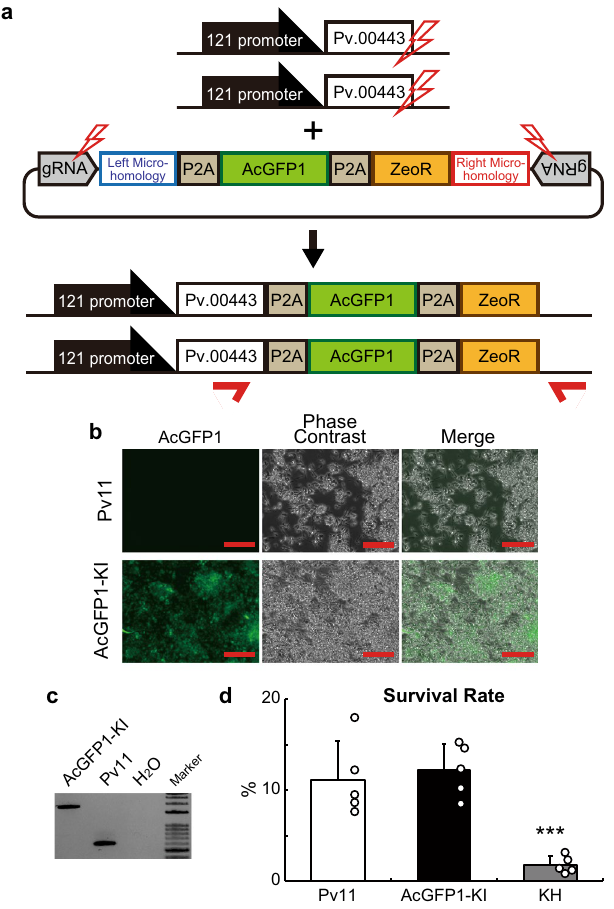
Figure 1. Insertion of the AcGFP1 and zeocin resistance (ZeoR) genes into the 5 ′ flanking site of the stop codon of the Pv.00443 gene. ( a ) The PITCh scheme for AcGFP1 and ZeoR knock-in is shown; the Cas9- and gRNA-expression vectors and the donor vector harboring AcGFP1 and ZeoR genes were transfected into Pv11 cells. Red arrows indicate the primers used in genomic PCR with gDNA obtained from cells after selection for zeocin resistance and AcGFP1 fluorescence. ( b ) Cell images were acquired with a conventional fluorescence microscope. ( c ) Genomic PCR from the cells was carried out (the whole gel image is in Supplementary Fig. S3). ( d ) Comparison of survival rate after desiccation-rehydration treatment of two cell lines stably expressing AcGFP1: targeted knock-in (AcGFP1-KI) and random integration-based (Pv11-KH) cells. An endogenous strong promoter, the 121 promoter, is located in the upstream region of the Pv.00443 gene. Scale bars, 100 µm. Values are expressed as mean ± SD; n = 5 in each group. ***p = 0.0008 (vs. Pv11) and 0.0003 (vs.